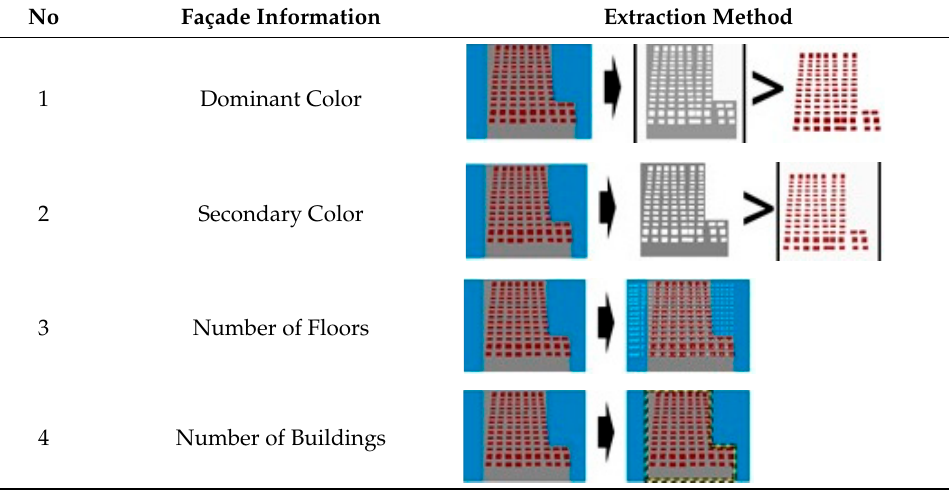
Table 6. Extraction of façade